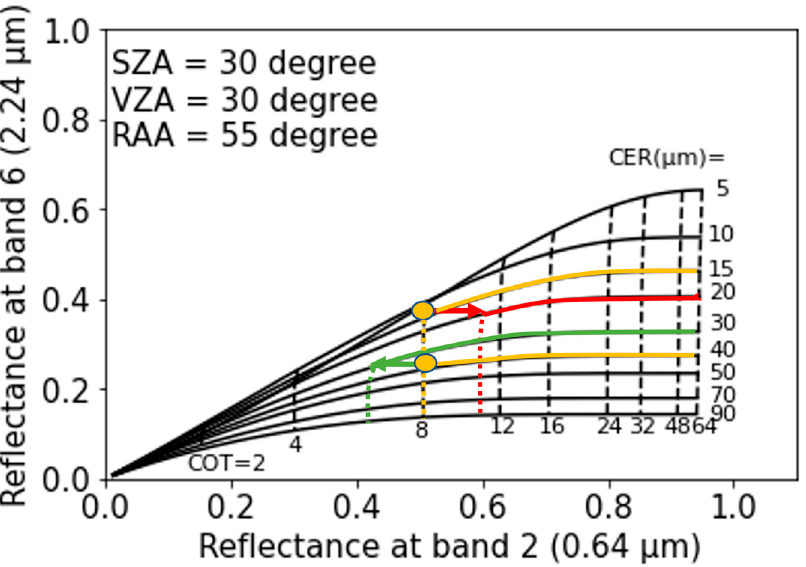
Figure 4. Nakajima–King schematic diagram based on the MODIS collection 6 ice particle model. The circular marks and lines in yellow correspond to the retrieval results from Case A, which is considered to be the benchmark. The red and green arrows indicate the circumstances that the reflectances from Case B or C are larger or smaller than the reflectance in Case A, and the lines in red and green stand for the corresponding COT and CER retrieval results, respectively.